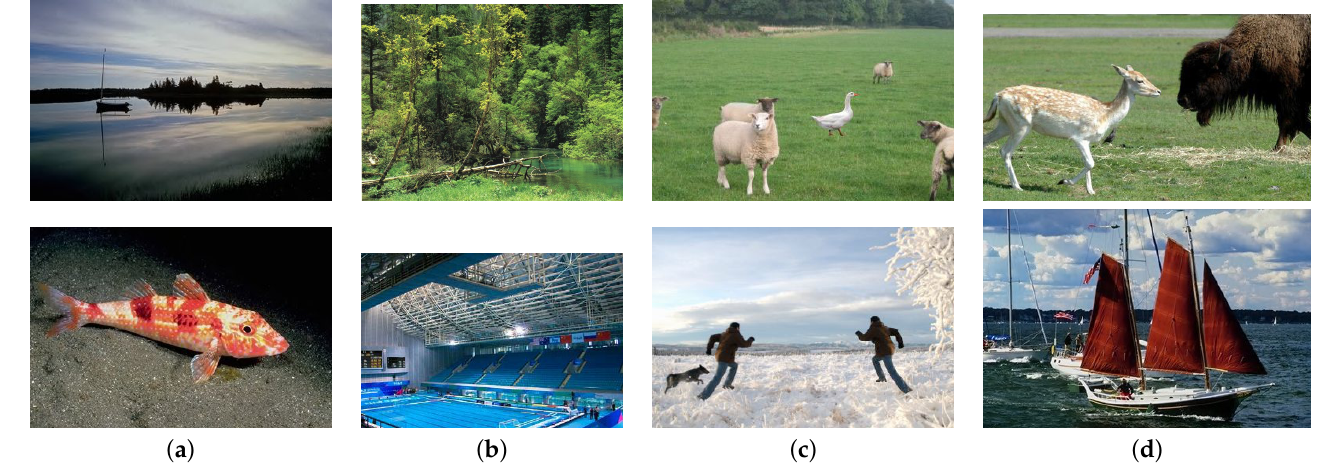
Figure 9. A few visual examples demonstrating the proposed approach’s performance: ( a ) true negative cases, ( b ) false negative cases, ( c ) true positive cases, ( d ) false positive